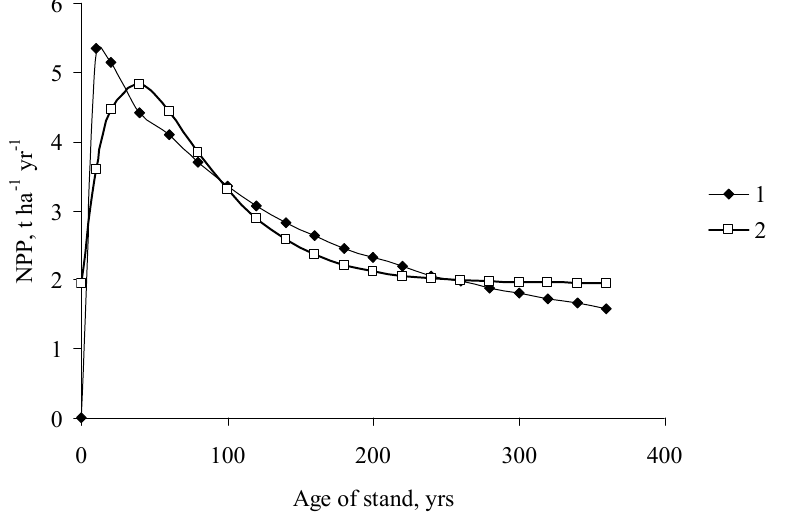
Figure 3. NPP calculation with the balanced Equation ( 1 ), taking into account root phytomass, and with the EcoSolow Equation ( 2 ). Larix gmelinii Rupr., Middle Siberia ([10], p. 589).